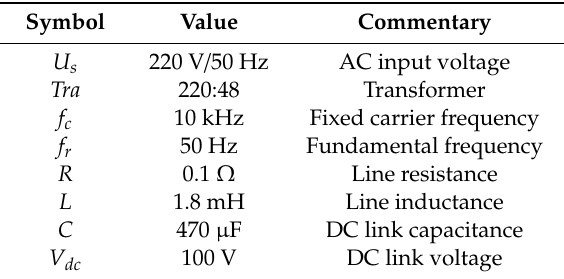
Figure 5. Comparison between the calculated spectrum and the simulated spectrum of the v DMS for the PWM APF. Table 1. Parameters of APF.